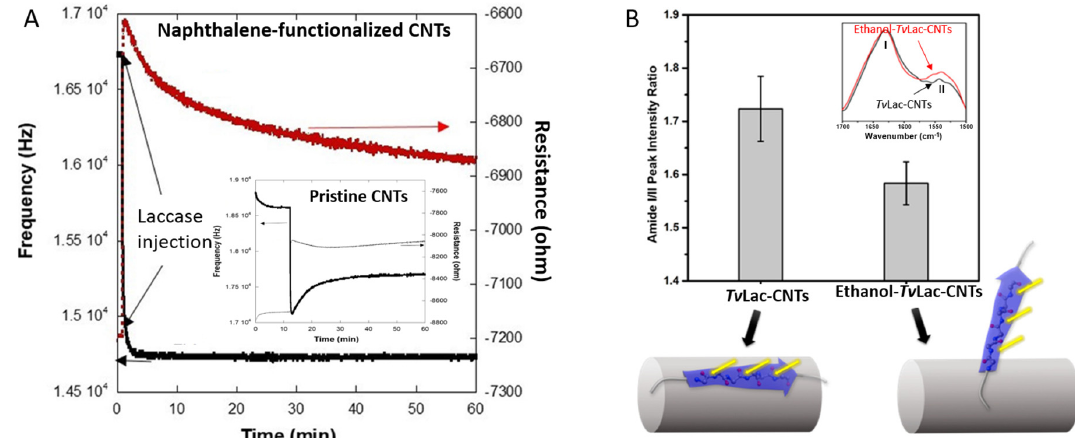
Figure 6. ( A ) QCM-D response of naphthalene-functionalized CNTs modified gold surface before and after Tr Lac injection. The inset shows the QCM-D response of pristine CNTs modified gold surface before and after Tr Lac injection. Reprinted from [82] Copyright (2020) with permission from Elsevier. ( B ) Two orientations of β -strand at the surface of CNTs predicted from the Amide I / II peak intensity ratios. Inset: Amide I and II band regions on di ff erence IR spectra (corrected by a linear baseline between 1700 and 1500 cm − 1 ) of the untreated Tv Lac-CNT film (black line) and Ethanol-treated Tv Lac-CNT film (red line). Yellow arrows represent incident light. Amide bonds (ball and sticks) are in the plane of β -strand. Reprinted from [85] Copyright (2017) with permission from American Chemical